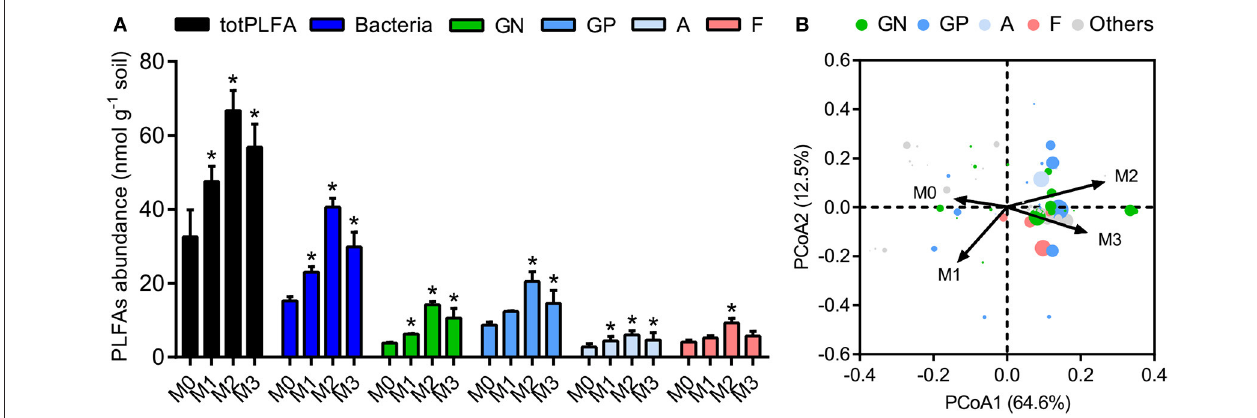
FIGURE 4 | The biomasses and structures of microbial communities in soil macroaggregates under manure treatments. (A) The biomasses of total PLFA (totPLFA) and functional groups including bacteria, Gram-negative bacteria (GN), Gram-positive bacteria (GP), actinomycetes (A), and fungi (F). Bars with * indicate significant differences ( P < 0.05) between manure additions and the M0 treatment, as revealed by one-way ANOVA with Bonferroni’s post-hoc test. (B) The structure of microbial communities was significantly influenced by manure treatments, as indicated by Bray-Curtis distances using principal coordinate analysis (PCoA). M0, no